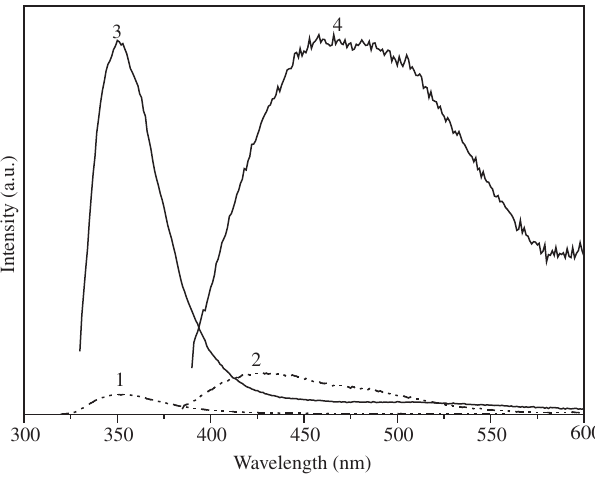
Figure 5. Fluorescence spectra of the stoichiometric DGEBA/DDM mixture (100:27 m/m) excited at: 1) and 3) 313 nm; 2) and 4) 370 nm. Dashed lines refer to the DGEBA/DDM mixture before heat-treating; full lines refer to the DGEBA/DDM mixture after heat-treating at 120 °C for 2 h (5 °C/min heating rate).